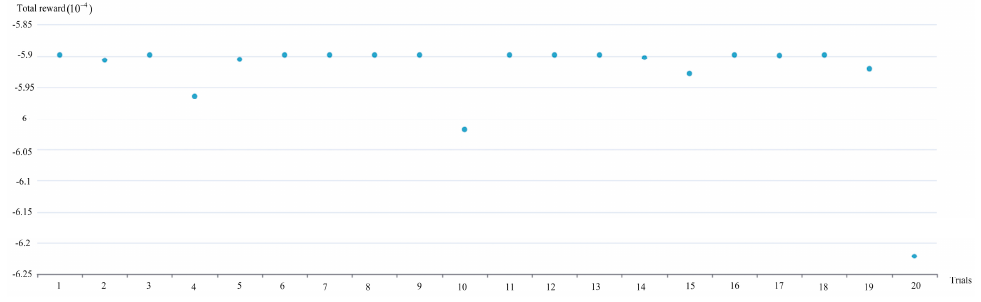
Figure 9. Total reward distribution under multiple trials.